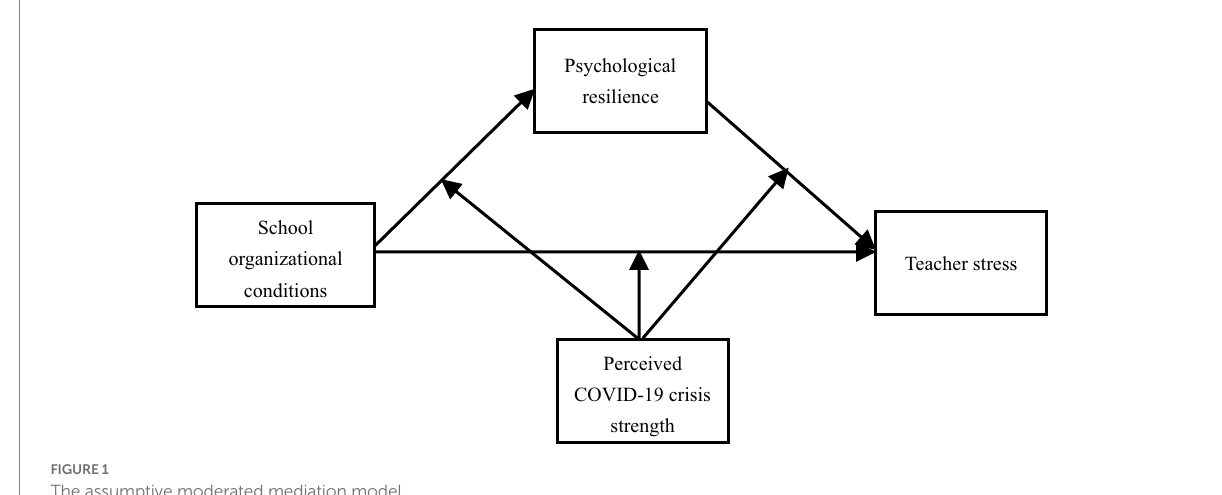
FIGURE 1 The assumptive moderated mediation